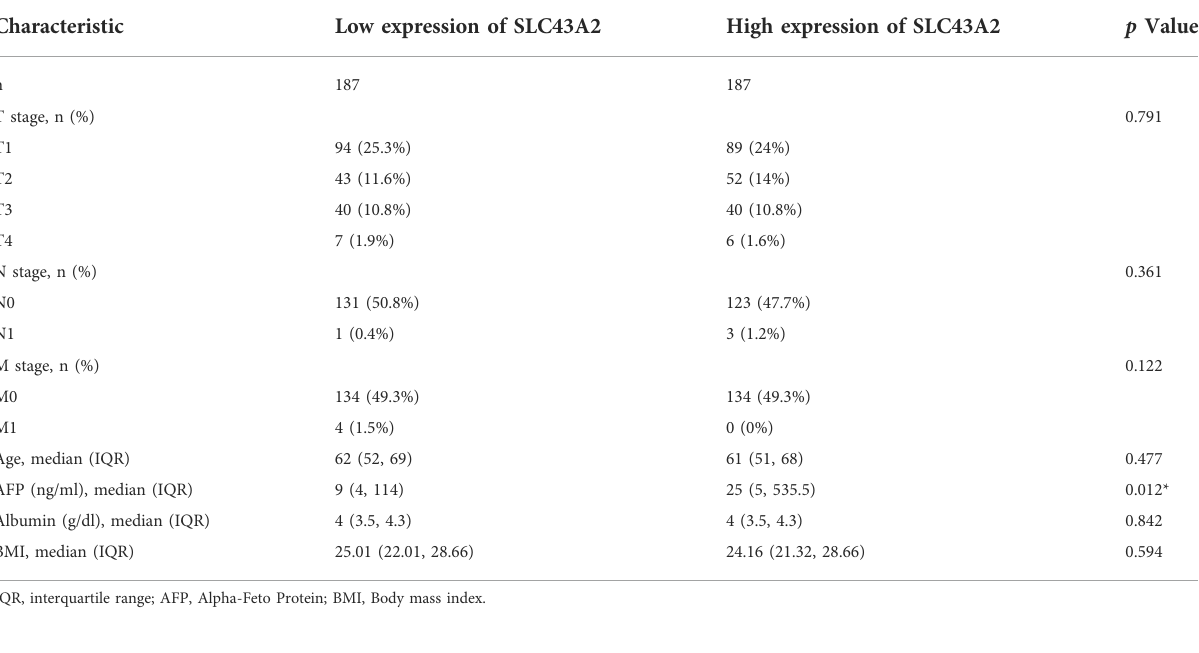
TABLE 1 The association between SLC43A2 expression and clinicopathological variables.